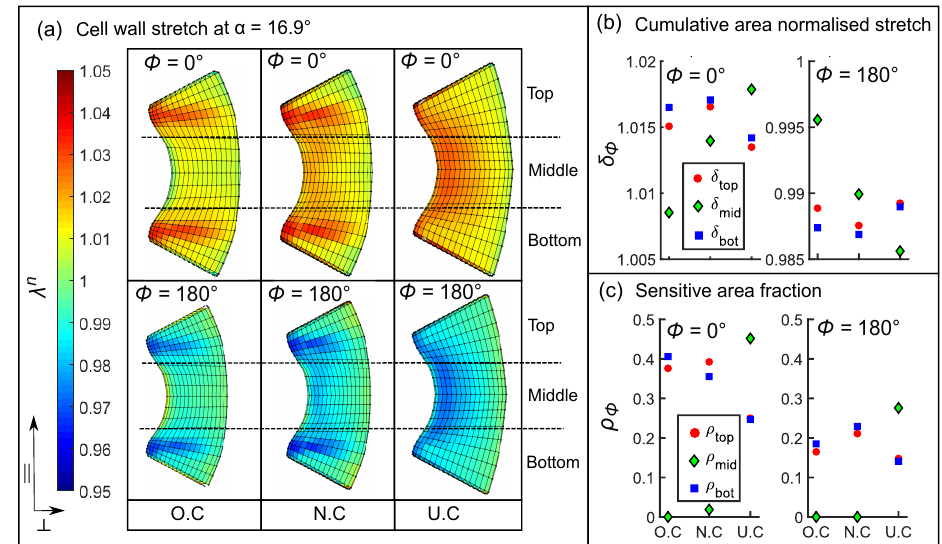
Figure 9. ( a ) Stretch λ n in the inner lumen surface of the two sensory cells located diametrically opposite each other at φ = 0 ○ ( top ) and φ = 180 ○ ( bottom ) at an angular displacement ( α = 16.9 ○ ), shown for the original cell (O.C), notchless cell (N.C) and the cell with uniform wall thickness (U.C). ( b ) Cumulative area-normalized stretch δ φ plotted for the O.C, N.C, and U.C at α = 16.9 ○ , in the top, middle, and bottom sub-regions on the inner lumen surface. ( c ) Sensitive area fraction ρ φ plotted for the sub-regions in the three cell shape types at α = 16.9 ○